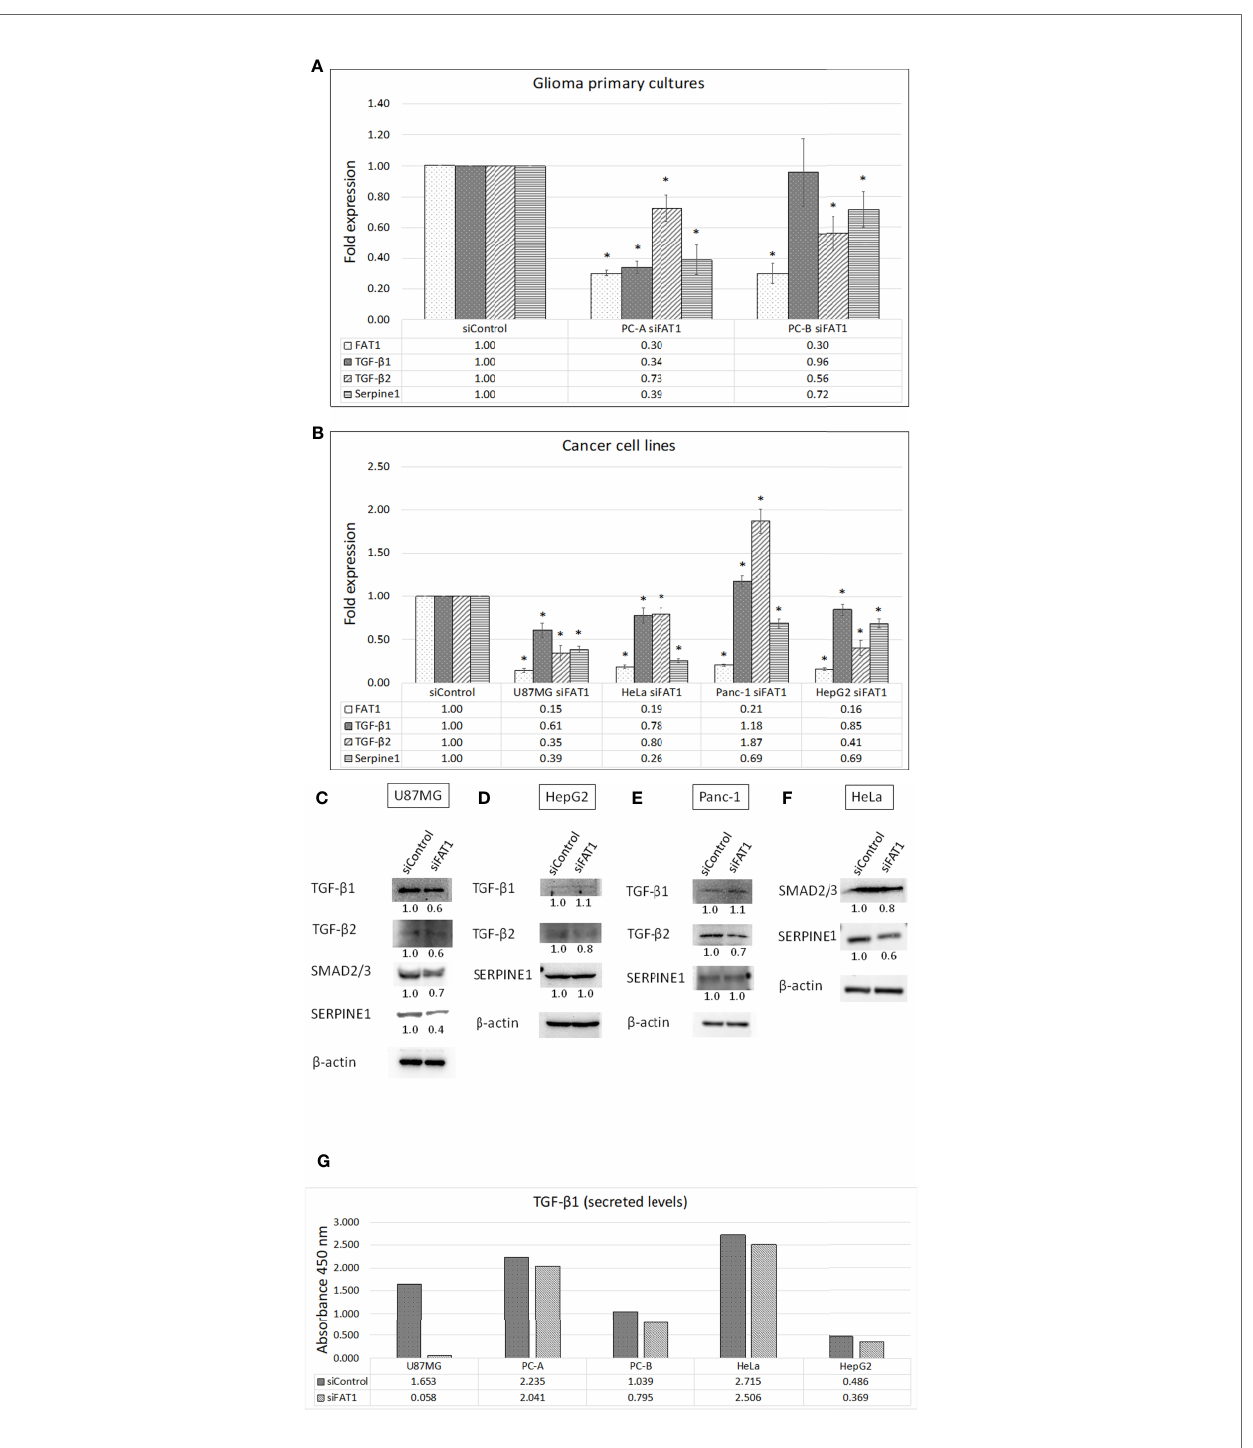
FIGURE 2 | Effect of FAT1 knockdown on the expression of TGF- b 1, TGF- b 2, and Serpine1 genes in (A) glioma primary cultures (PC-A: grade II oligodendroglioma; and PC-B: GBM) and (B) representative cancer cell lines (U87MG, HeLa, Panc-1, and HepG2) as assessed by q-PCR. Relative gene expression in each siFAT1 sample has been normalized to its respective siControl sample. (*) indicates p-value ≤ 0.05. (C – F) Western blots showing the expression of TGF- b 1/2 pathway molecules (TGF- b 1, TGF- b 2, SMAD2/3 dimer, SERPINE1/PAI-1) in whole-cell lysates of siFAT1 cells vs. siControl cells (U87MG, HepG2, Panc-1, and HeLa) at 72 h of FAT1 knockdown. In this study, b -actin was used as the loading control. Densitometric values of the proteins analyzed with respect to b -actin have been provided below the blots. (G) Graph showing optical densities of TGF- b 1 cytokine secreted by siControl cells vs. siFAT1 cells in U87MG, PC-A, PC-B, HeLa, and HepG2 culture supernatants depicting the modulation of cytokine release by tumor cells upon FAT1